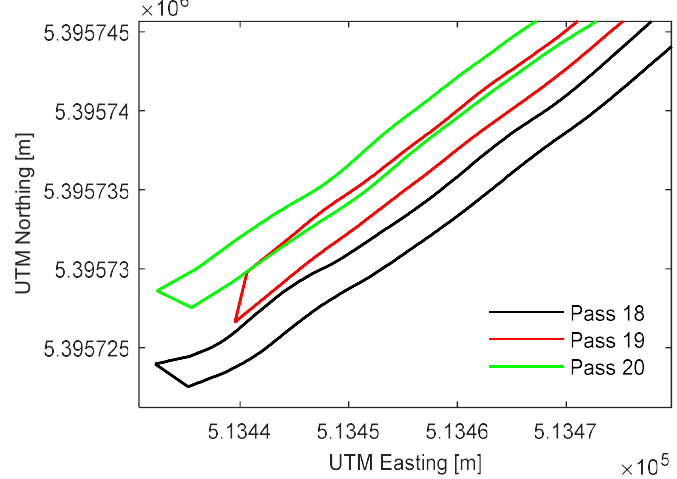
Figure 14. Zoom of the polygons formed from three exemplary cultivated tracks.